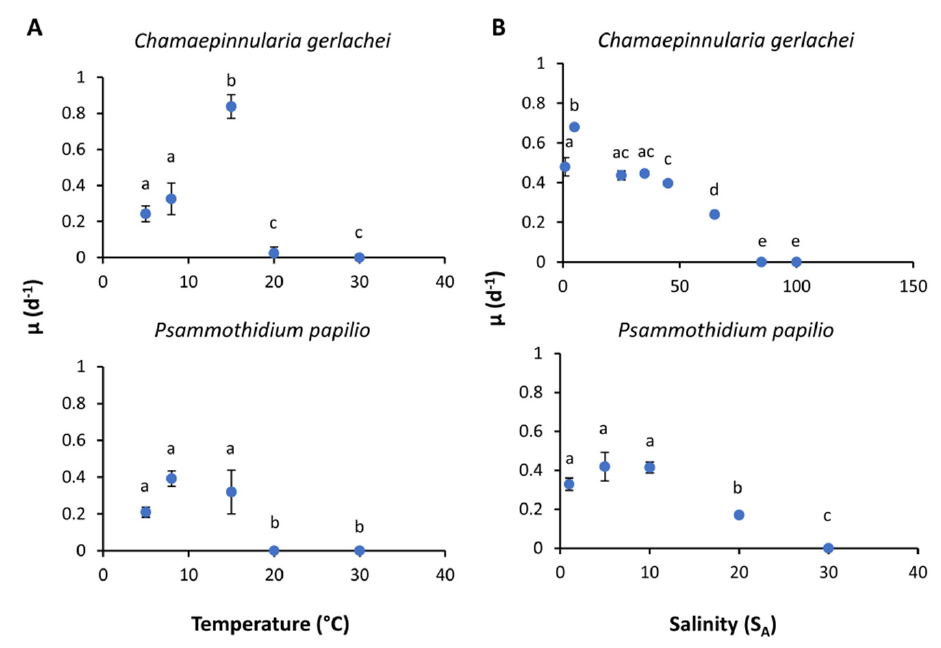
Figure 10. Growth rates ( µ d − 1 ) in relation to ( A ) temperature and ( B ) salinity of the respective diatom strains Chamaepinnularia gerlachei and Psammothidium papilio . Data represent mean values ± SD ( n = 3). Different lowercase letters represent significance levels among all means, as calculated per temperature or salinity by one-way ANOVA (Tukey’s test, p < 0.05). Please note the different salinity ranges for both species.